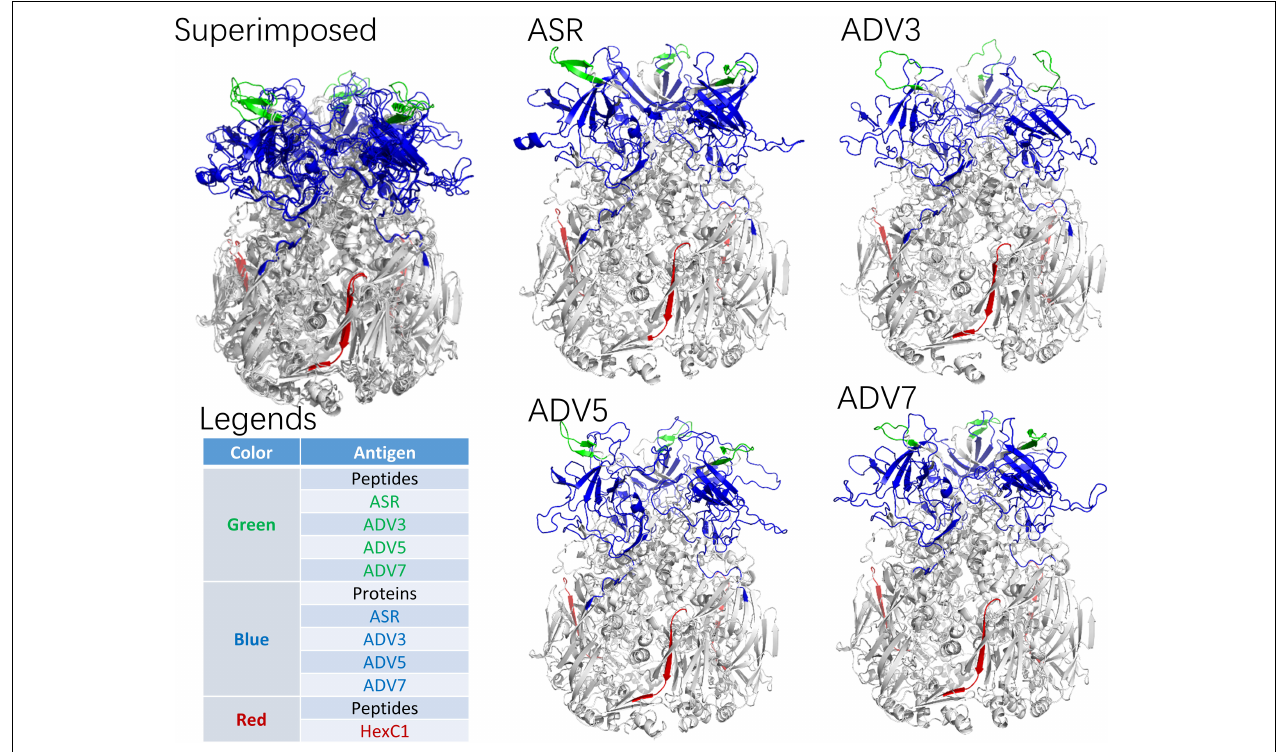
FIGURE 5 | Spatial Location of synthesized antigen peptides and proteins on Hexon Trimers in this study. The ASR was the hexon model of ancestral sequences, also called N1M1 in main text. ADV3 was the hexon model of human adenovirus type 3 strain GB. The ADV5 was the hexon model of human adenovirus type 5, which was adopted from 1P30 in RCSB (PDB) database. The ADV7 was the hexon model of human adenovirus type 7 strain Gomen. The antigen polypeptides were colored with red or green, while the antigen protein segments were colored with blue.